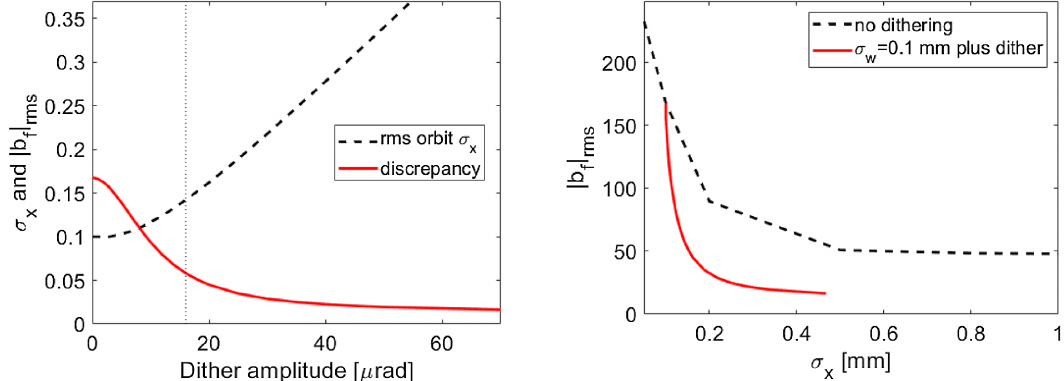
FIG. 5. Left: the rms orbit σ x (dashed black) and the discrepancy j b rms j (solid red) as a function of the dither amplitude, which allows us to assess the trade-off between spoiling the orbit and learning the response matrix. Right: the solid red line shows j b f j rms plotted versus σ x . The black dashed line shows the effect of purely random variations, already shown in Fig. 3, for 1 = 3 from 0 . 168 m = rad to 0 . 056 m = rad. This configuration is indicated by the vertical dotted line in Fig. 5.